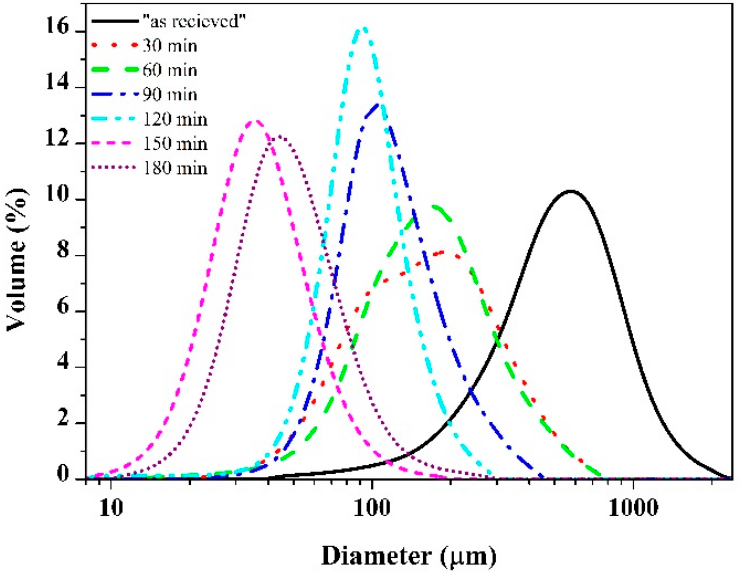
Figure 2. Particle size distribution of the Ti 50 Cu 25 (Ni 80 Sn 20 ) 25 powders after different milling times.